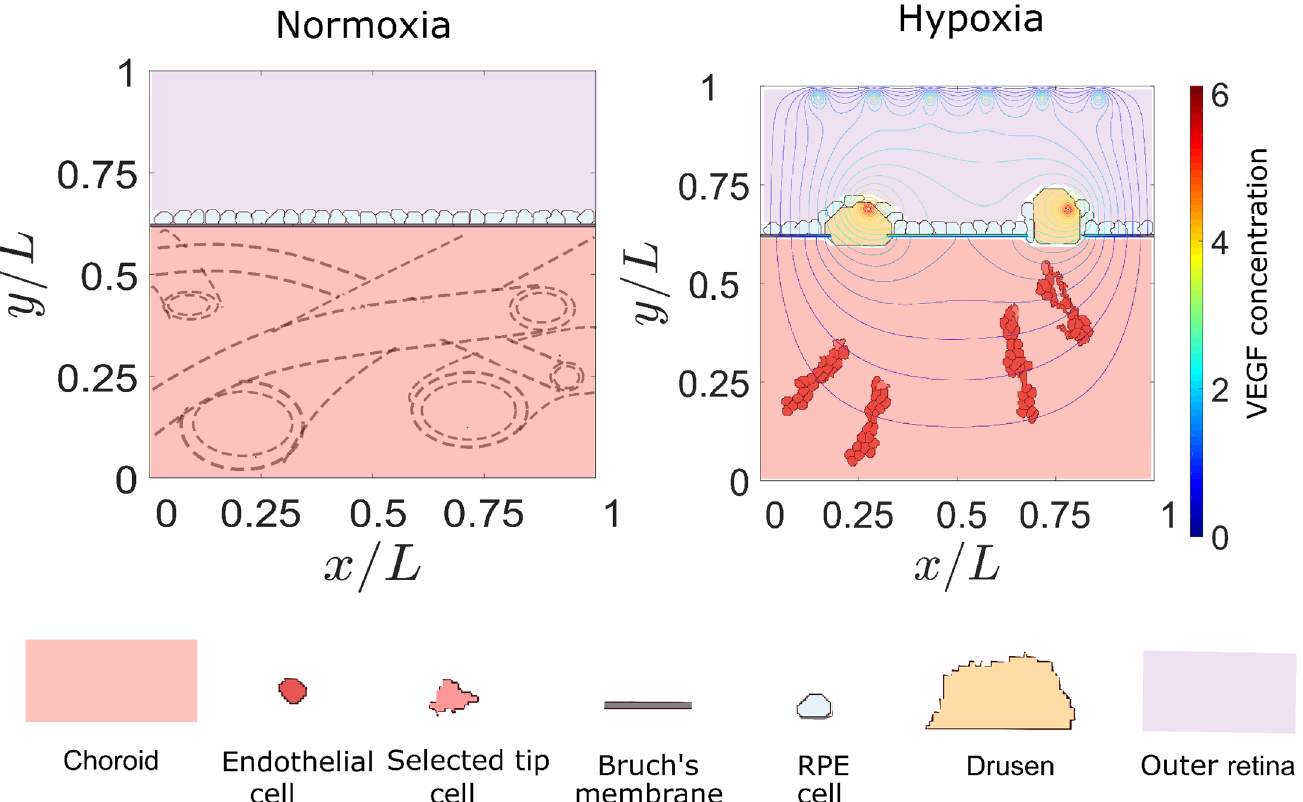
Figure 1. Sketch of a two-dimensional section of the macula, including choroid and choroid blood vessels, Bruch’s membrane, retinal pigment cells, drusen, outer retina, epithelial cells, and tip cells. Left panel: normal supply of oxygen. Right panel: hypoxia and incipient choroid neovascularization.